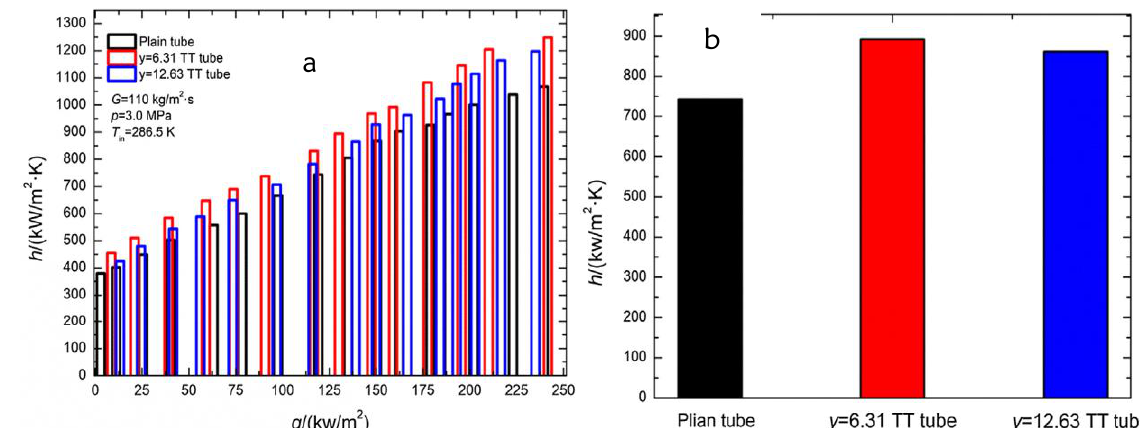
Figure 2: (a) Heat flux and average HTC variation in the plain and TT tubes. (b) The overall heat transfer performance for TT tubes and the plain tubes